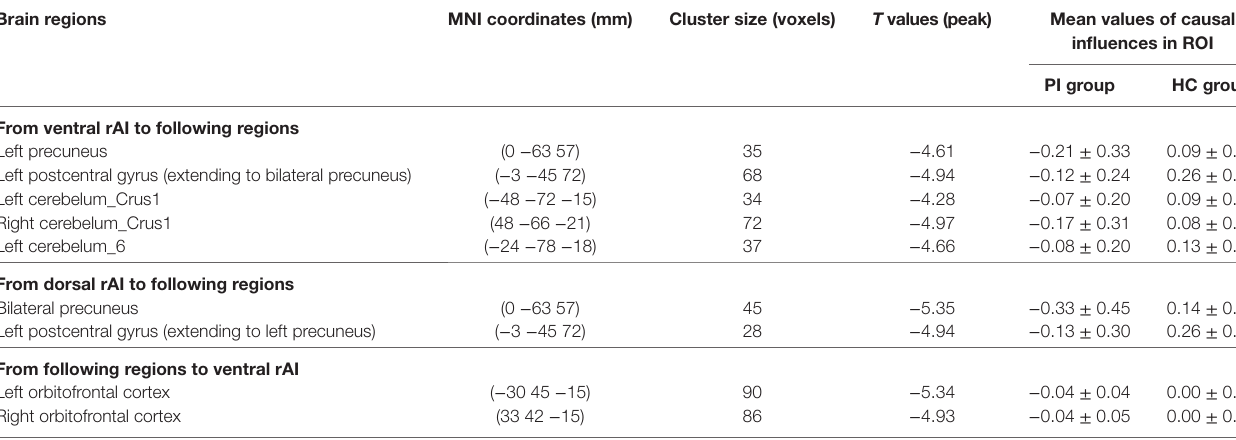
Table 2 | Between-group differences in Granger causal